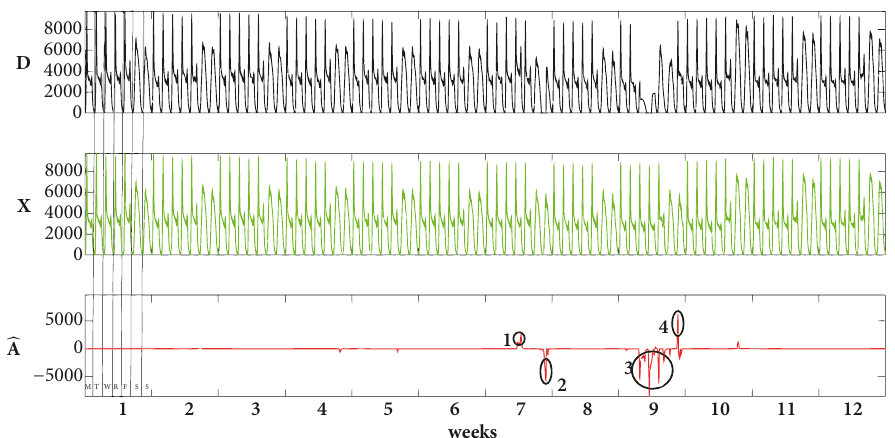
Figure 5: Component decomposition of exit flow of Xidan station by the improved RPCA. The horizontal axis is time interval covering 12 weeks, and the vertical axis is flow